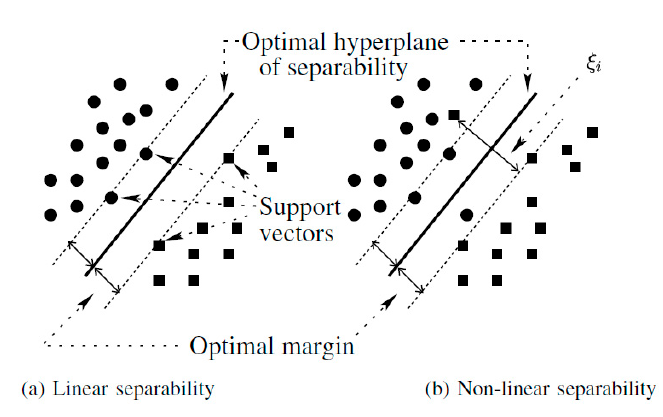
Figure 4. Support Vector Machine classifier.